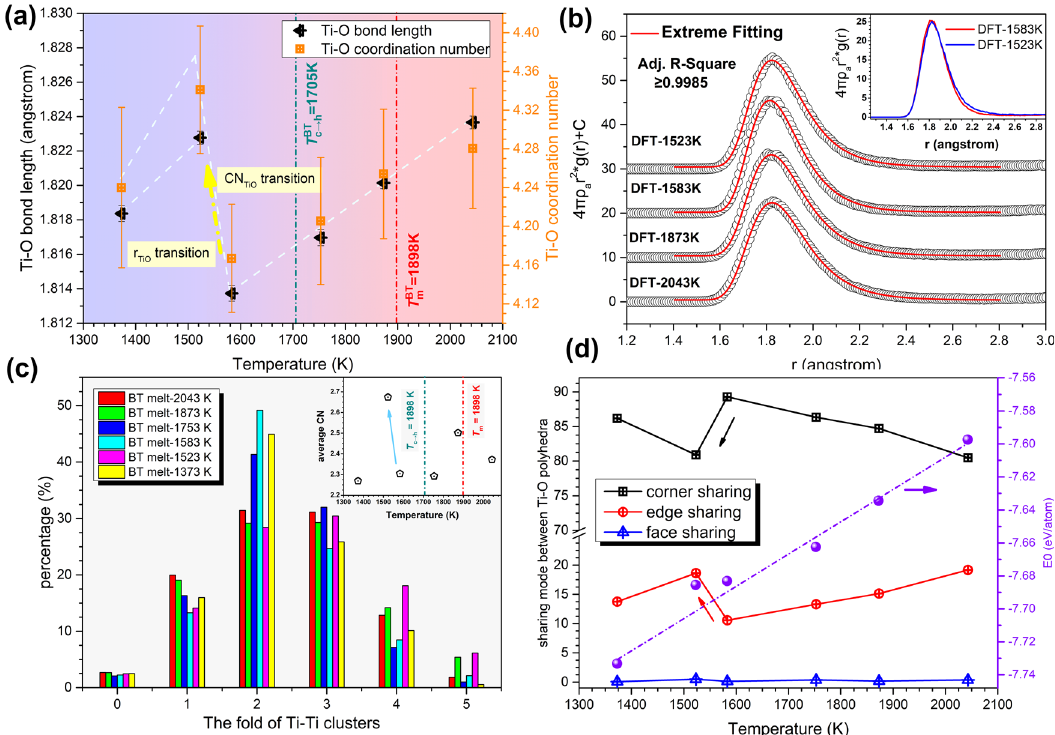
Fig. 6 The structural transition scenario embodied by AIMD ensembles. a Temperature dependence of Ti – O polyhedra structural parameters. The error bars correspond to the standard deviation of Ti – O coordination number based on 5000 con fi gurations. b Comparison of the Ti – O partial radial distribution function (RDF) before and after the structure transition. c Variation of the fold of Ti – Ti clusters. The inset fi gure presents the variation of Ti – Ti total coordination number with temperature. d Connectivity between Ti – O polyhedra as a function of temperature; in addition, the variation of average energy per atom ( E 0 ) with temperature is also plotted in this fi